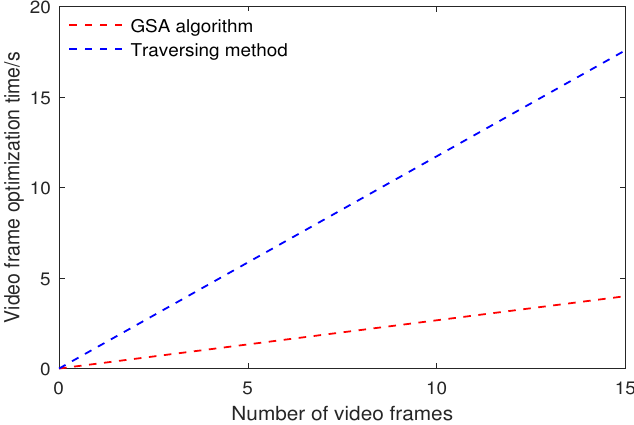
Figure 9. Gravitational Search Algorithm (GSA) and traversal method time comparison